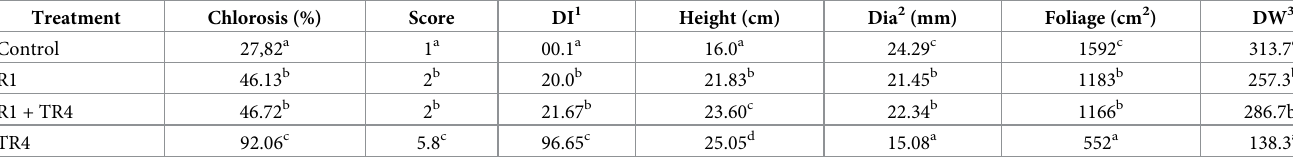
1 DI = disease index. 2 Dia = pseudostem diameter (mm). 3 DW = dry weight (g).